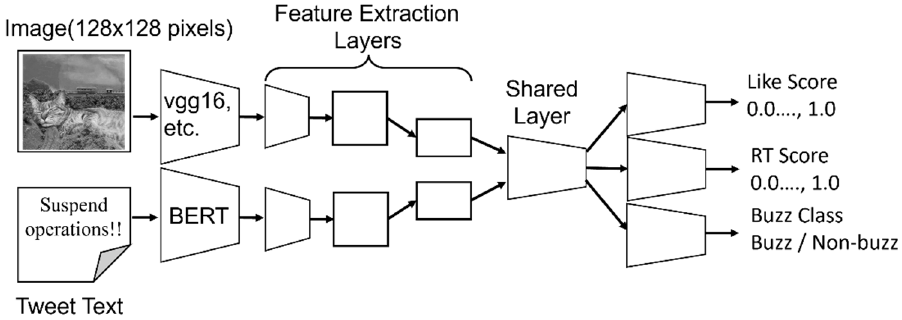
Figure 1. Multi-task learning to predict the number of likes/RTs and the buzz class.